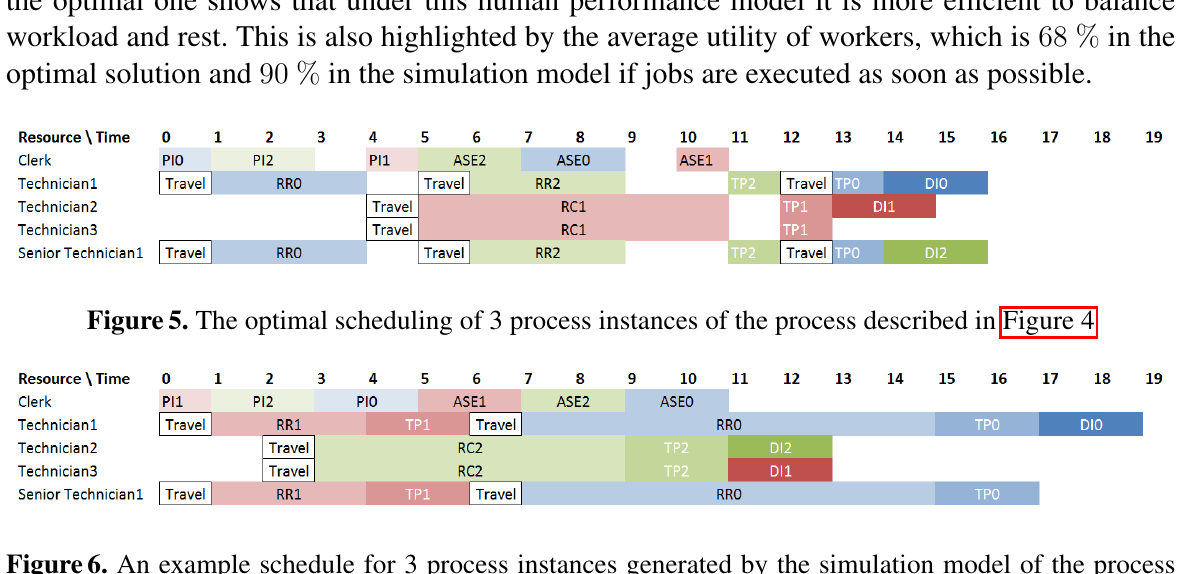
Figure 6. An example schedule for 3 process instances generated by the simulation model of the process described in Figure